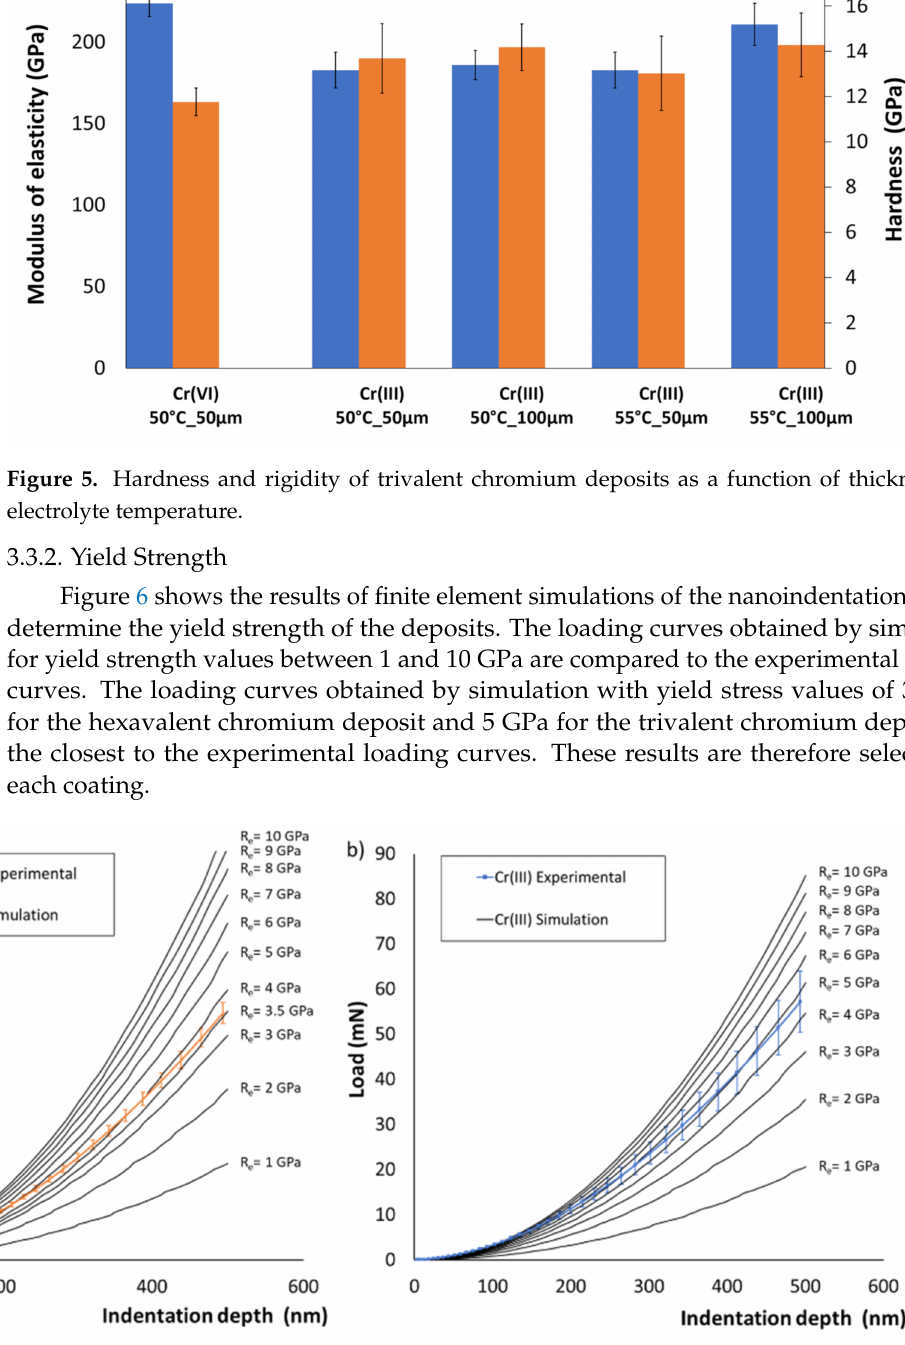
Figure 6. Comparison of the evolution of the applied force as a function of the indented depth determined experimentally and by simulation: deposits of ( a ) hexavalent and ( b ) trivalent chromium. Loading curves obtained by simulation for yield strength values between 1 and 10